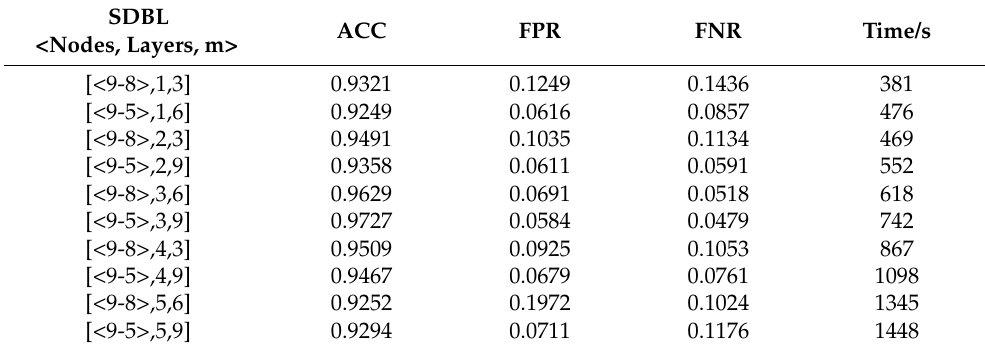
Table 1. Performance of SDBL model with different